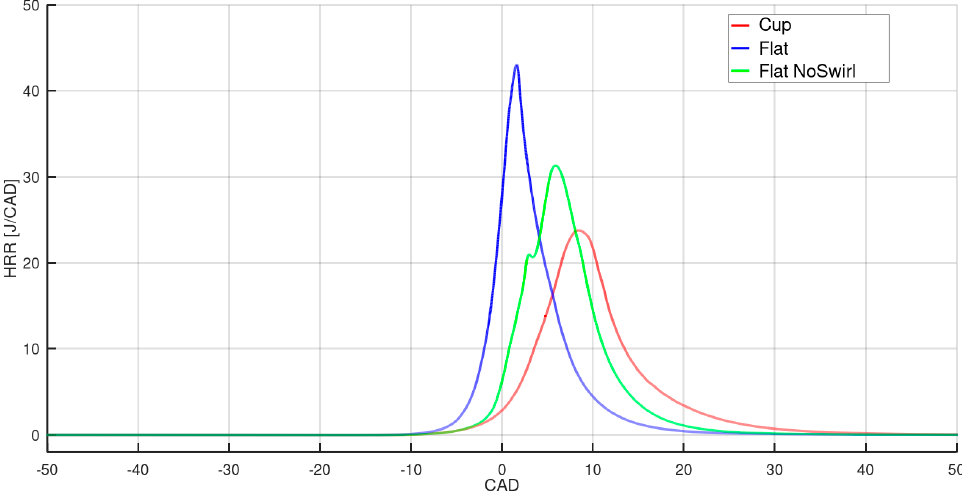
Figure 17. Heat release rate for the three cases. Table 3. CAx crank angles when x% of total heat has been released, and combustion duration for three cases